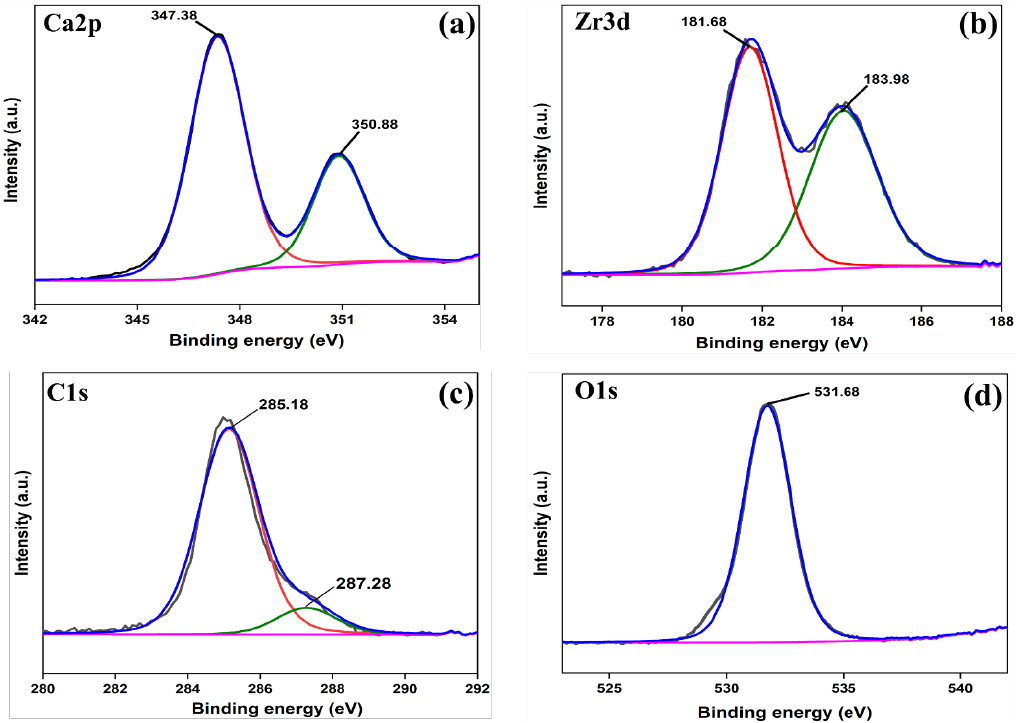
Figure 7. Representative deconvoluted XPS pattern of ( a ) Ca2p, ( b ) Zr3d, ( c ) C1s and ( d ) O1s.